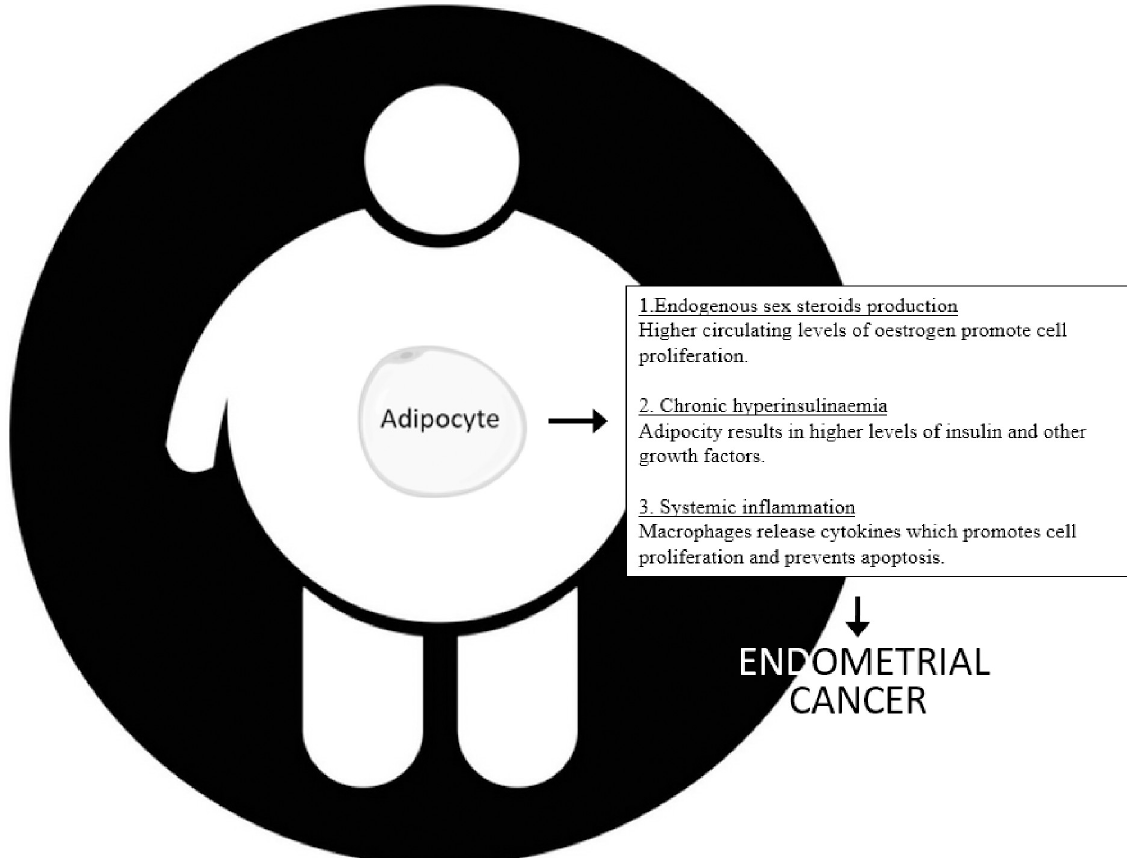
Fig 1. Three main hypotheses for the development of endometrial cancer in obese women.